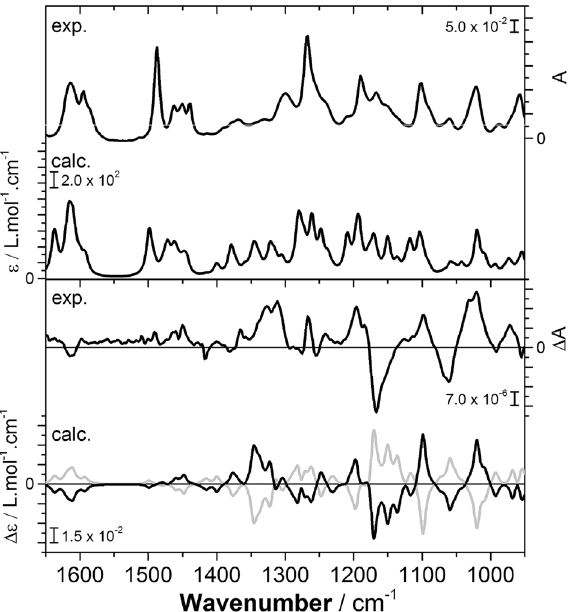
Figure 3. Experimental IR (top) and VCD spectra (bottom) of ( −)-tatiomicin 3 (CDCl 3 ) with predicted spectra obtained at the B3LYP/PCM/6–311 + + G(d,p) level of theory. VCD: Solid line = (2 R ,3 R ,4 S ,4a S ,10 S ), dashed line = (2 S ,3 S ,4 R ,4a R ,10 R ). Spectra have been frequency scaled Black line (σ = 0.987) to yield maximal similarity grey line between the computed and experimental VCD spectra.